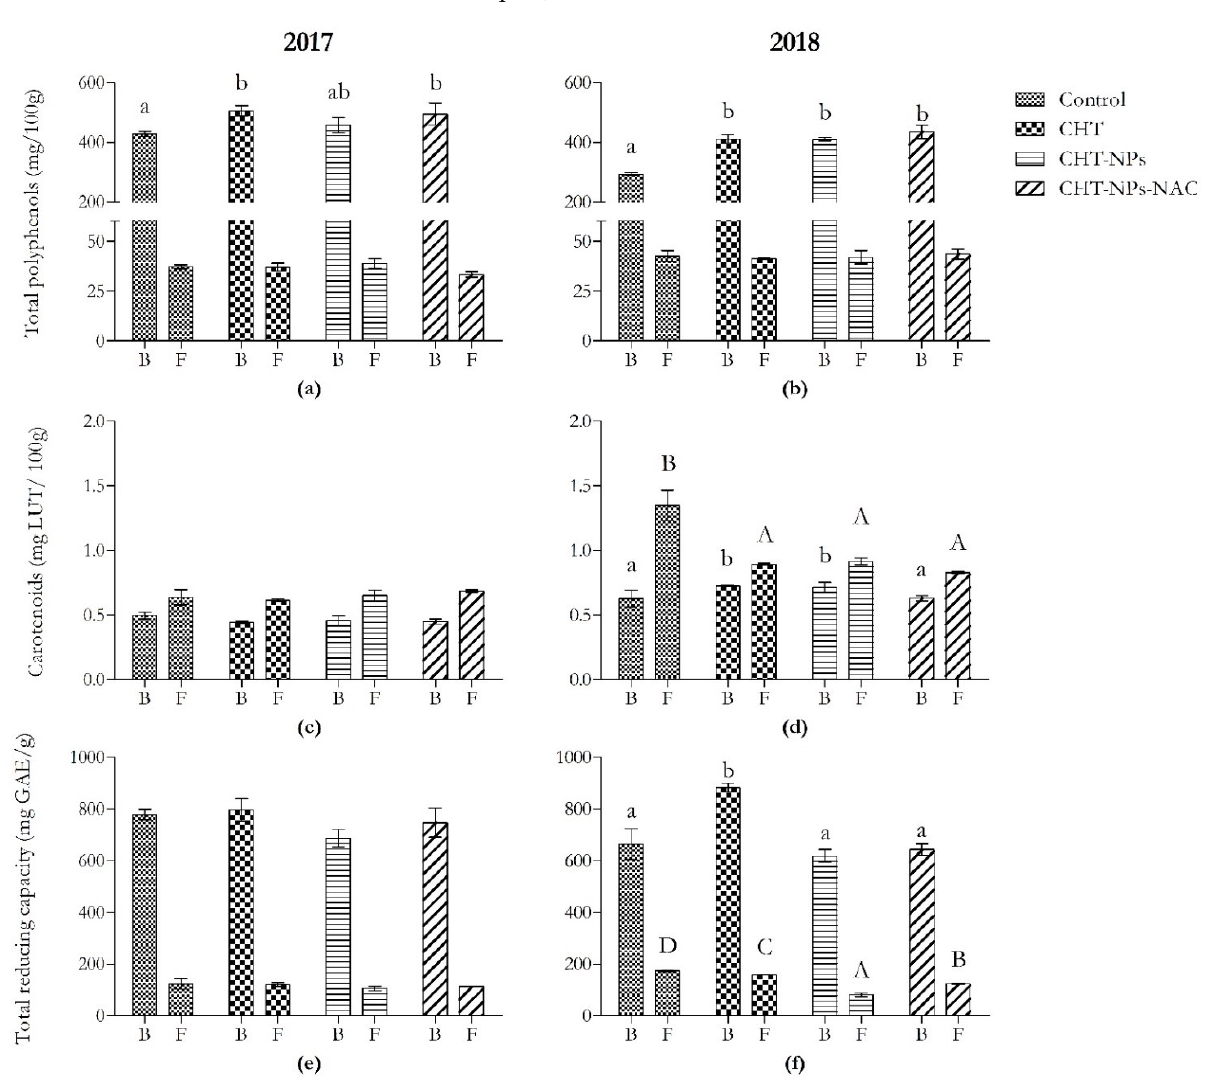
Figure 1. Content of total polyphenols, carotenoids, and total reducing capacity in bran and semolina obtained from Triticum durum (cv. Fabulis) in 2017 ( a , c , e ) and 2018 ( b , d , f ), untreated (Ctrl) or treated with CHT, CHT-NPs, or CHT-NPs-NAC. Bars represent mean ± standard deviation ( n = 3). Different uppercase and lowercase letters indicate significant differences among treatments in bran and semolina, respectively, according to Tukey’s post-hoc